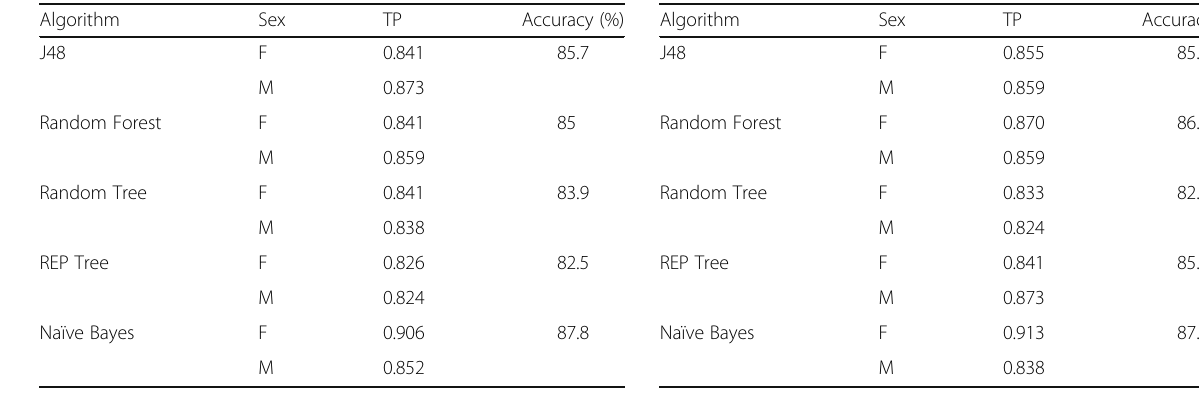
Table 5 Accuracy rates for sex determination through algorithms using toe lengths and toe length